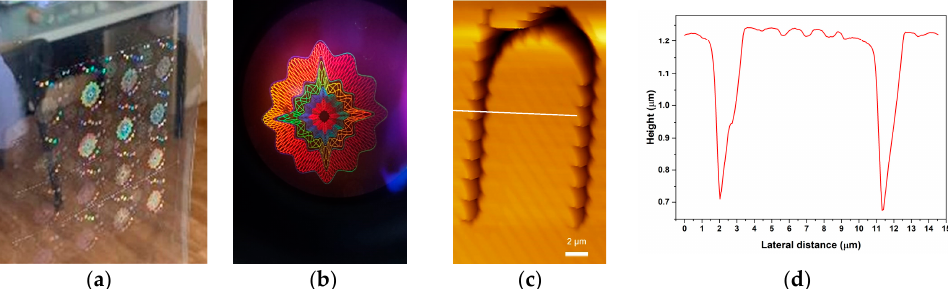
Figure 10. Developed holographic foil image: ( a ) overall image; ( b ) detail through the objective of the optical microscope; ( c ) AFM image of text with sub-micron line width “hidden” in the holographic background; and ( d ) pro fi le.